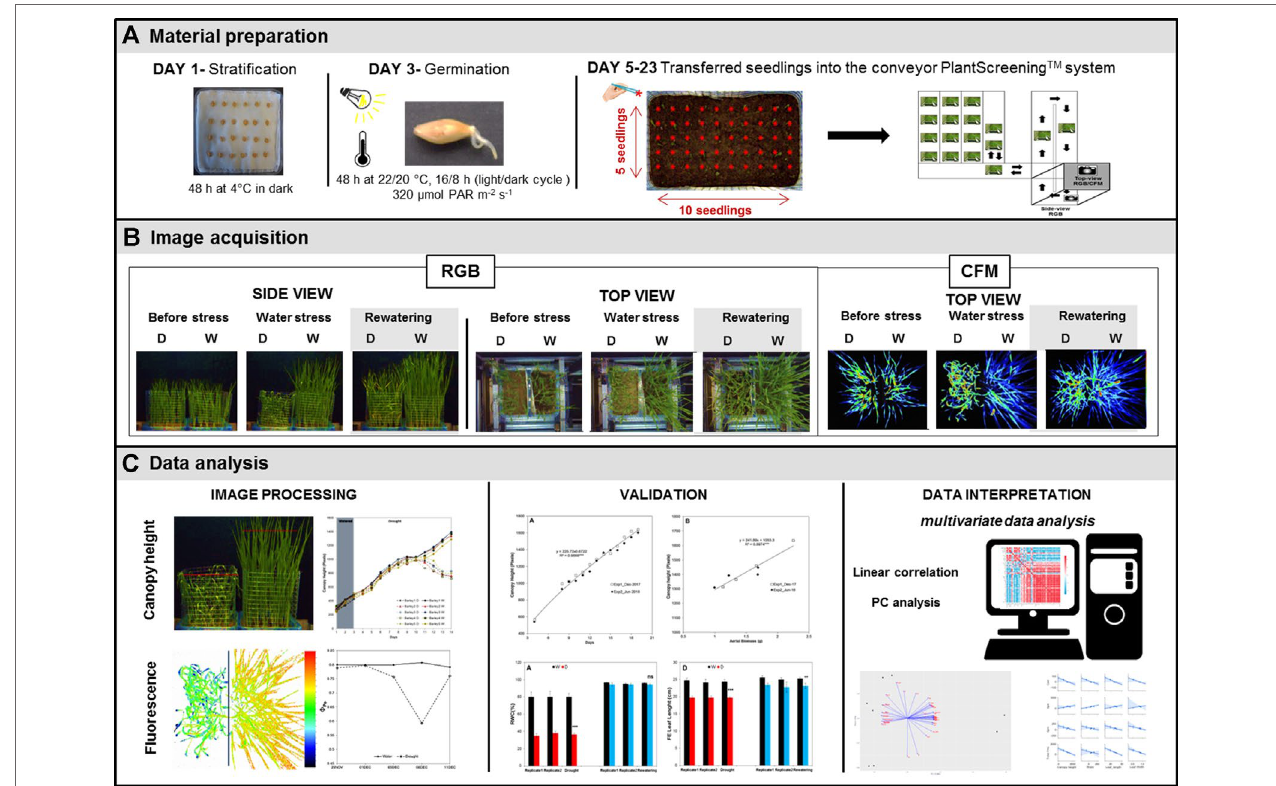
FIGURE 1 | Scheme of the protocol used for non-invasive phenotyping of barley ( Hordeum vulgare ) seedlings growing under water stress conditions. (A) Barley seeds were germinated on filter paper and 50 seedlings of similar radicle size were transplanted into soil in standardized PlantScreen™ measuring trays. (B) The trays were transferred to an XYZ PlantScreen™ chamber with a conveyor system for automatic image acquisition. (C) The canopy height was analyzed using an in-house software routine implemented in MatLab R2015, and the data were evaluated by multivariate statistical analyses using Phyton version 3.6.5 and R version